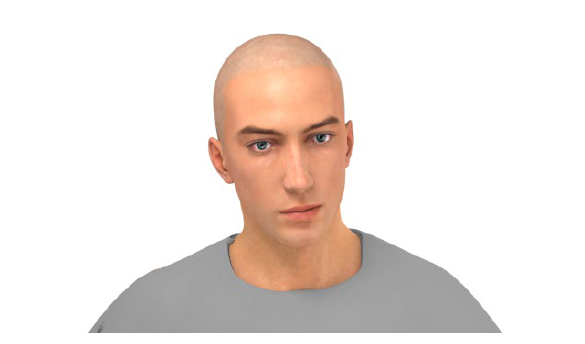
Figure 7 | Human-like